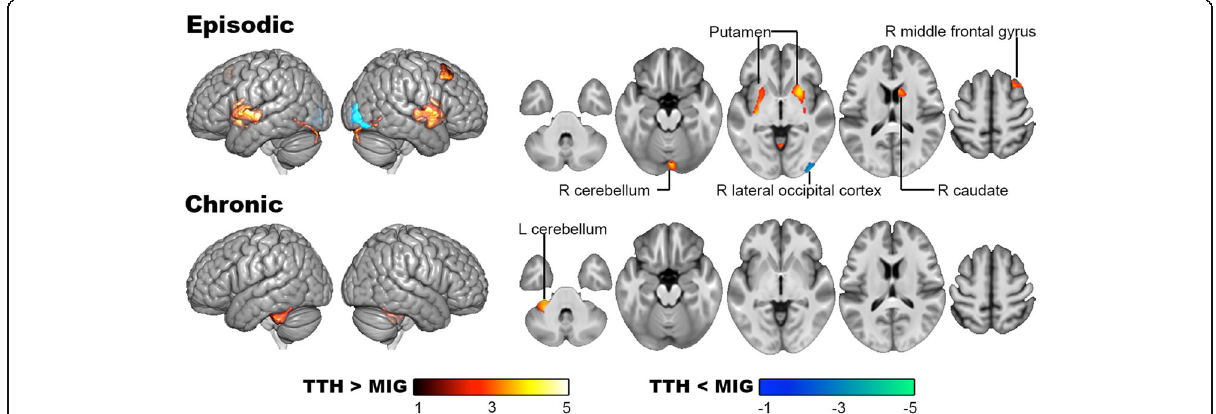
Fig. 3 Post-hoc analysis for the gray matter volume difference between TTH and migraine (2×2 ANCOVA). The episodic TTH vs. episodic migraine groups demonstrated a higher gray matter volume in the bilateral putamen, right caudate, middle frontal gyrus, and cerebellum. Conversely, gray matter volume of the right lateral occipital cortex was lower in episodic TTH compared with episodic migraine. A comparison of gray matter volume between chronic TTH and chronic migraine only revealed a higher gray matter volume of the left cerebellum in chronic TTH. L: left; MIG: migraine; R: right; TTH: tension-type headache